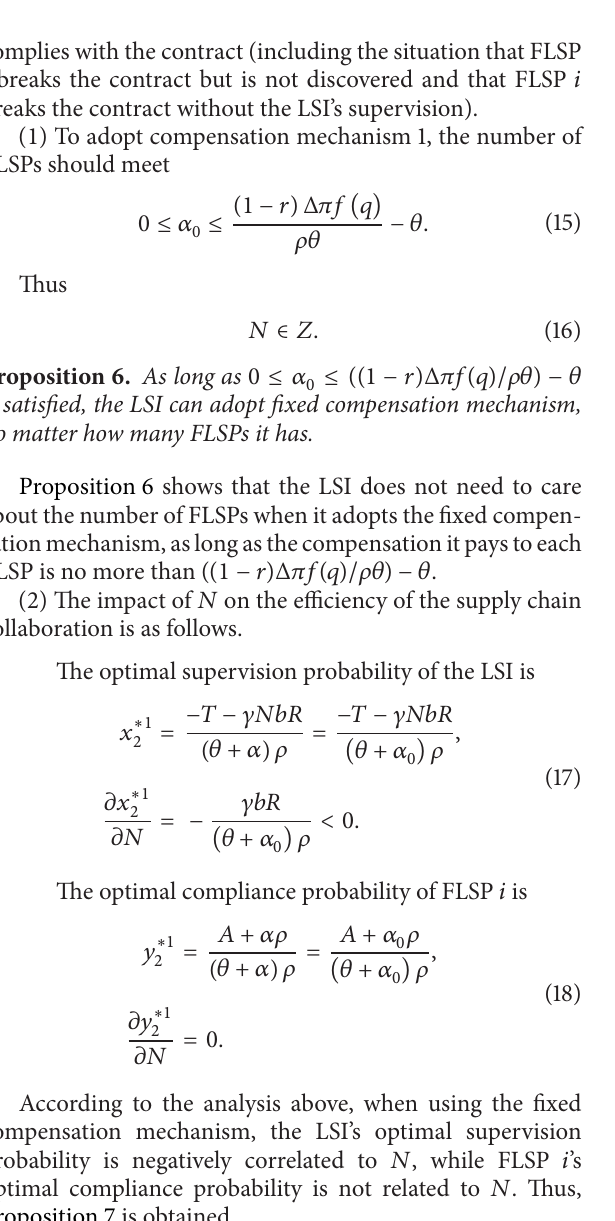
Table 3: Expected revenue matrix of LSI and FLSP 𝑖 with FLSPs’ competition under a compensation mechanism. LSI Complies with the contract Breaks the contract